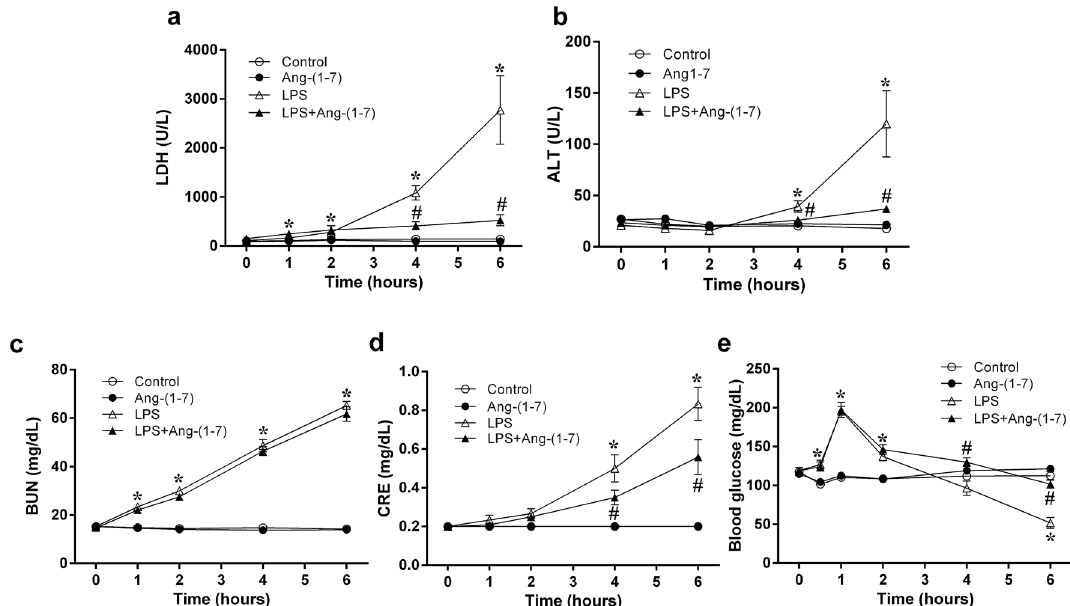
Figure 2. Angiotensin-(1–7) improves liver and kidney dysfunction and ameliorates delayed hypoglycaemia in endotoxaemic rats. We assessed the changes in lactate dehydrogenase (LDH) ( a ), alanine aminotransferase (ALT) ( b ), blood urea nitrogen (BUN) ( c ), creatinine ( d ), and blood glucose ( e ) levels during the experimental period in rats infused with 0.9% NaCl (control, n = 6), angiotensin (Ang)-(1–7) (1 mg/kg for 3 h, n = 6), E. coli lipopolysaccharide (LPS, 10 mg/kg for 15 min, n = 12), or LPS plus Ang-(1–7) (1 mg/kg for 3 h at 0.5 h after LPS, n = 12). The data are shown as the mean ± standard error of the mean. *, p < 0.05 for LPS vs. control. # , p < 0.05 for LPS + Ang-(1–7) vs. LPS.